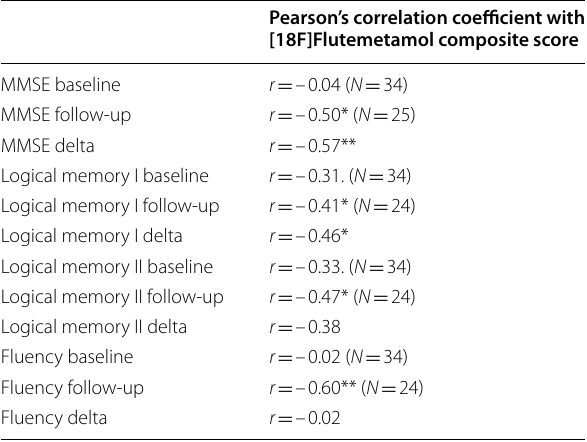
Table 4 Associations between 18 F-Flutemetamol composite scores and cognitive test results